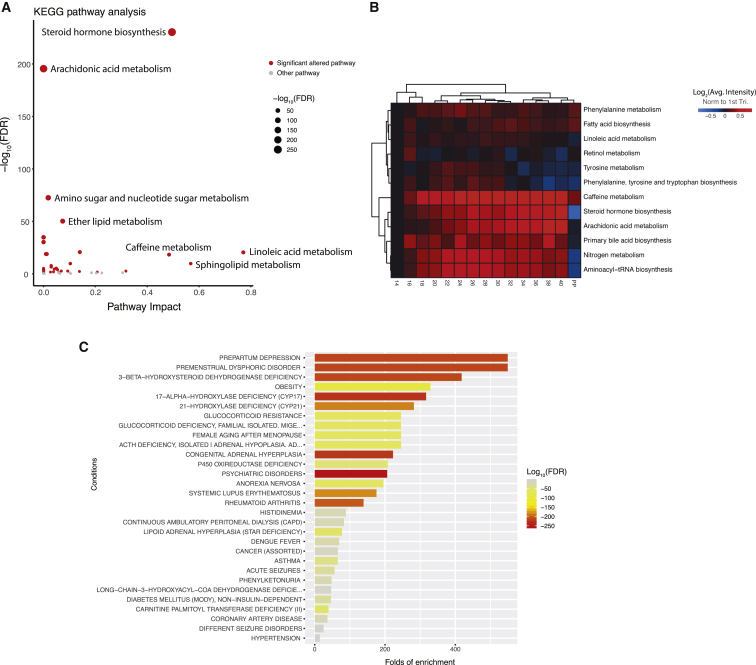
System-Wide Reconfiguration of Metabolic Pathways during Pregnancy(A) Metabolic pathways undergoing significant changes during pregnancy. Red dots denote pregnancy-related pathways with FDR < 0.05, which were further analyzed in (B). The topological pathway effects were quantified by using published methods (Xia and Wishart, 2010a).(B) Heatmap shows the temporal changes of pregnancy-related pathway activities during pregnancy and postpartum (PP). To quantify pathway activity, the average intensity of metabolites in each pathway at each time window was calculated. Note that although some pathways contained mainly the metabolites increasing or decreasing during pregnancy, many pregnancy-related pathways contained both metabolites increasing and decreasing. Thus, their average values would not show large changes in the heatmap. For each pathway, the average values from samples earlier than 14 weeks (marked as week 14) were used as the baseline.(C) Human disease states that correlated with pregnancy-related metabolites on the basis of published metabolomics data (Chong et al., 2018).See also Figure S3.